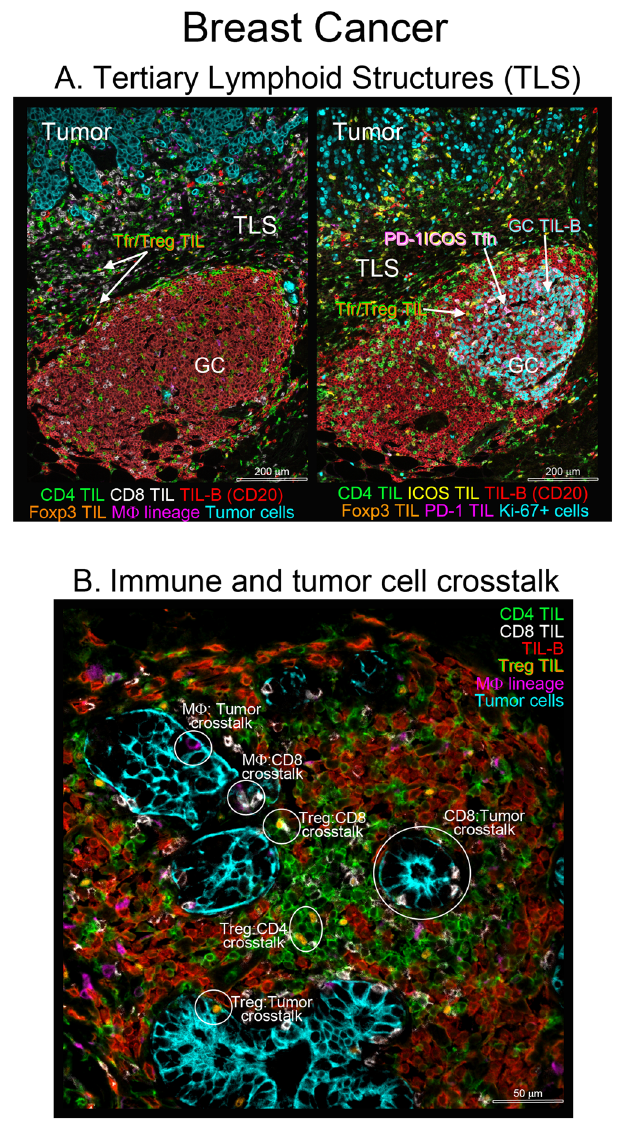
Fig. 1 Tertiary lymphoid structures and immune cell crosstalk in the breast cancer immune microenvironment. Breast tumor tissue sections from surgical resections (formalin- fi xed and paraf fi n-embedded; FFPE) analyzed using multiplex immunohistochemistry. A Upper left image: region of an untreated primary breast tumor showing multiplex IHC- stained tumor cells (pan CK, cyan) with immune cells in stromal localized TLS. TIL include CD4 (green) and CD8 (white) T cells, B cells (CD20, red), Tfr/Treg [Foxp3 (orange nucleus) plus CD4 (green membrane)] and macrophage lineage (CD68, magenta); upper right image: consecutive section of the same tumor region showing CD4 T cells (green), B cells (CD20, red), ICOS + cells (yellow), Tfh [their pink/white color is a combination of three surface markers: PD-1 (magenta), ICOS (yellow) and CD4 (green)], Tfr/Treg [Foxp3 (orange nucleus) plus CD4 (green membrane)] and proliferating cells (Ki-67 + , cyan; both B cells and tumor cells). B Enlarged region of TIL surrounding tumor islets in a residual tumor surgically resected following pre-surgical treatment. Multiplex IHC-stained tumor cells (pan CK, cyan) and TIL including CD4 (green), CD8 (white), B cells (CD20, red), Treg [Foxp3 (orange nucleus) plus CD4 (green membrane)] and macrophage lineage (CD68, magenta) are shown with examples of the crosstalk between these cells shown in circles (white). mIHC slides were scanned at ×20 magni fi